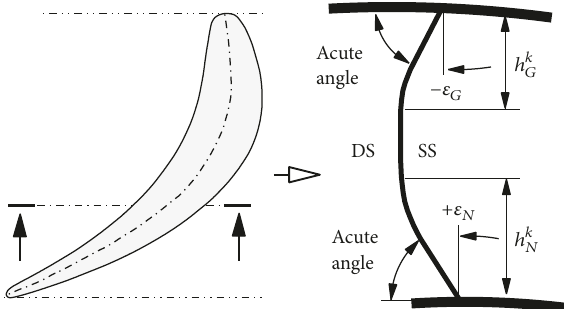
Figure 1: Definition of guide vanes curved on both ends by its stacking line in 𝑆 3 -plane.